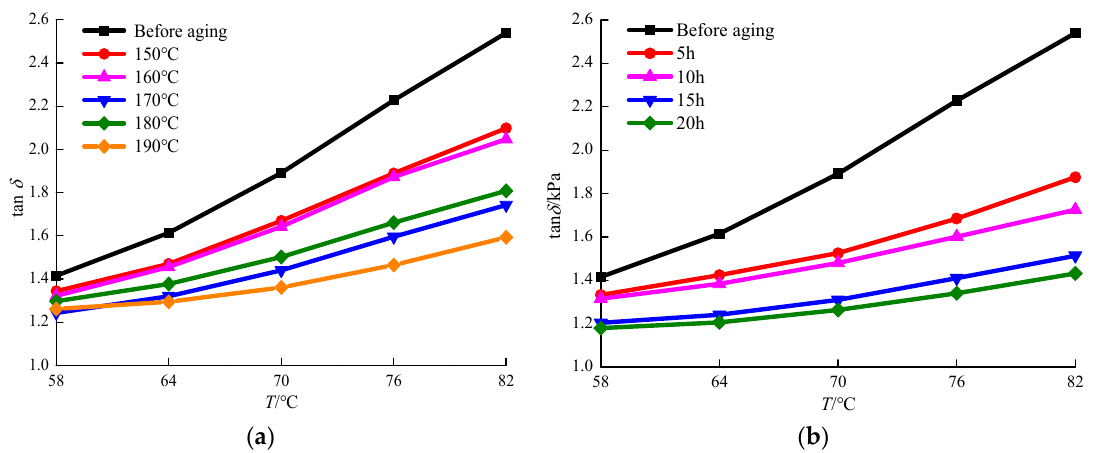
Figure 7. tan δ values of MACRMA at different aging conditions: ( a ) aging temperature and ( b ) aging time.